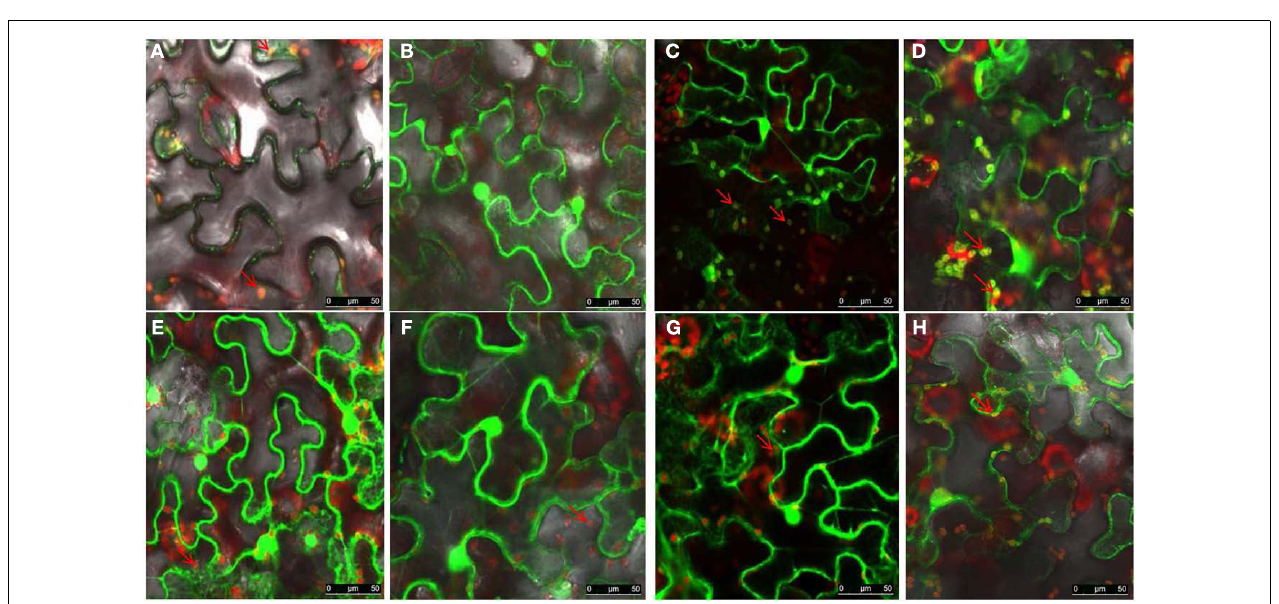
pCHF3-NSvc4 ∆ 106–125 -eGFP (H) . At 48h post agroinfiltration the leaves were sampled and examined under a confocal microscope.The fluorescence emission was collected simultaneously, with one photon multiplier-tube bandwidth set at 500–530 and 660–700nm, respectively. Arrows indicate the sphere-like compartments and the